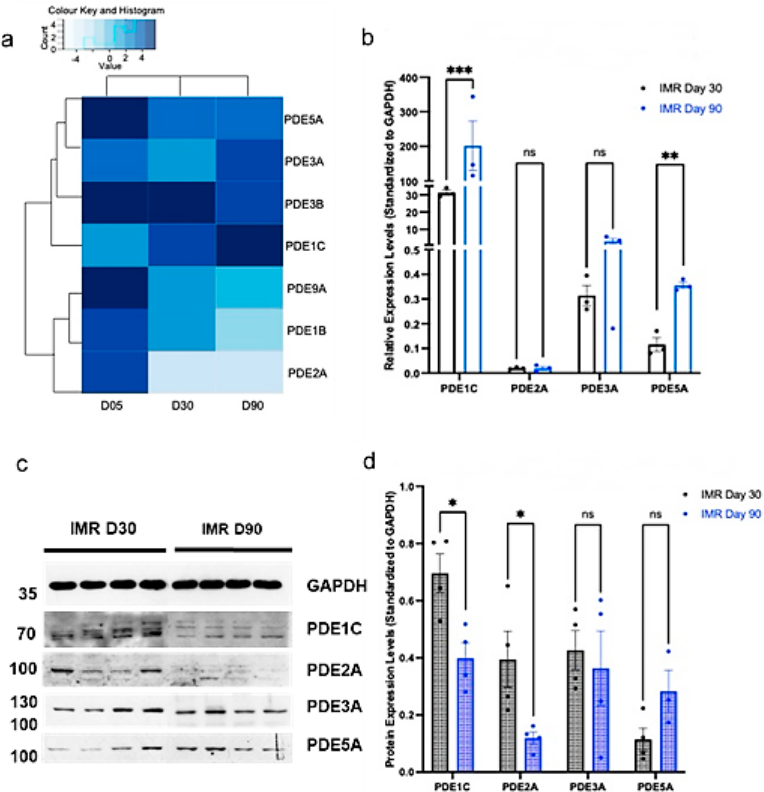
Figure 2. Phosphodiesterase (PDE) gene and protein expression in IMR90 induced pluripotent stem cell cardiomyocytes (IMR-hPSC-CM) aged day 5, 30, and 90. ( a ) Heatmap representing the expression of cGMP-hydrolysing PDEs from the RNA-SEQ dataset in IMR-hPSC-CMs aged day 5, 30, and 90. ( b ) Gene expression of PDEs in IMR-hPSC-CMs cultured for 30 and 90 days. Western blot depiction ( c ) and protein expression quantification ( d ) of PDEs in IMR-hPSC-CMs cultured for 30 and 90. *—p < 0.1; **—p < 0.01; ***—p < 0.001.